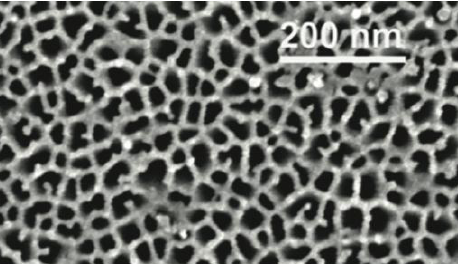
Figure 1. SEM image of a network of palladium (Pd) nanowires with a deposition thickness of 7